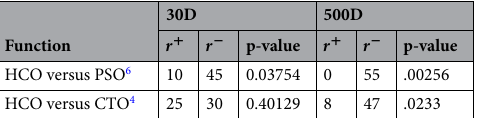
Table 7. Wilcoxon-signed test for CEC2020 BMFs at significant stage α = 0.05 .